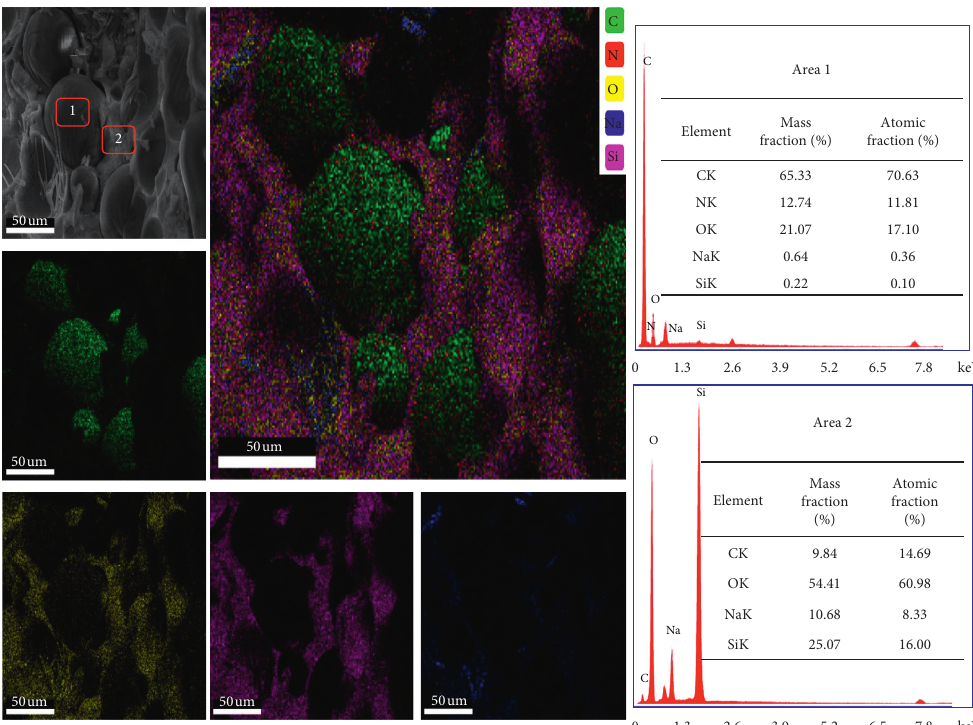
Figure 12: Element distribution of the C17-1% sample.